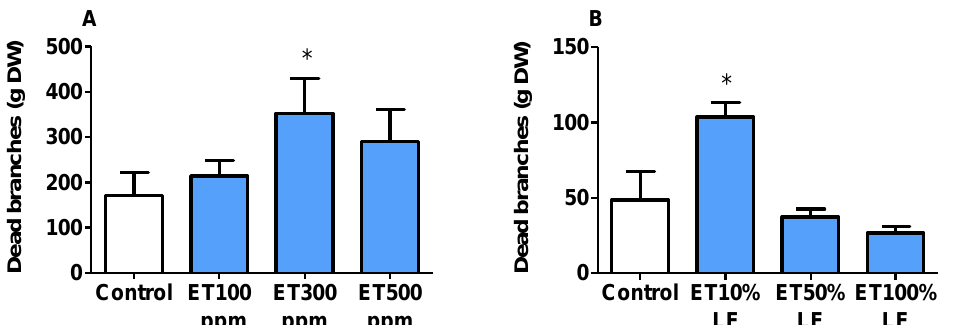
Figure 6. Ethephon effects on injury of peach ‘Redhaven’ ( A ) and ‘Sunhigh’ ( B ). Injury was evaluated by weighing the total dead branches from each tree 6 WAFB. Each bar represents the mean + SE of size n = 6. Asterisk * indicates significant difference between ET treatment and the control at p < 0.05. ET, ethephon; LF, leaf fall.